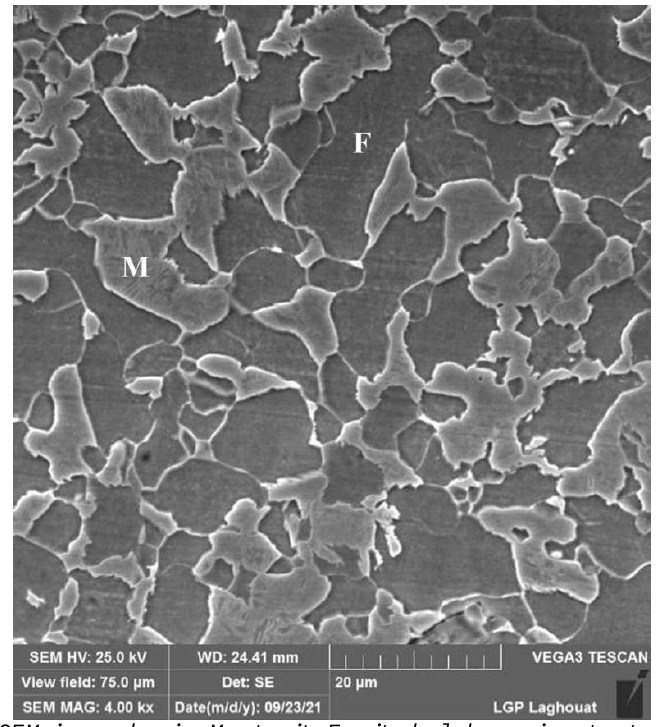
Fig. 2. SEM image showing Martensite-Ferrite dual phase microstructures of the specimen intercritically annealed at 800